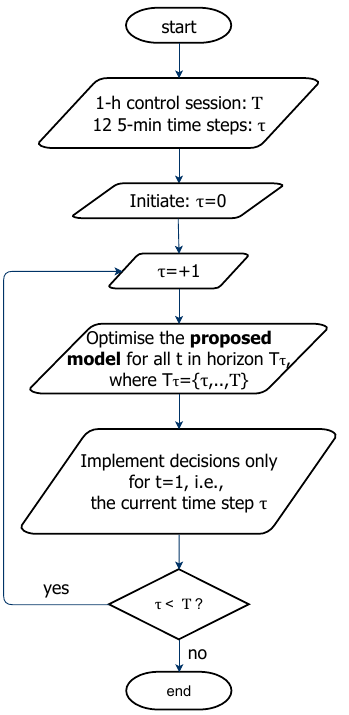
Figure 4. Flow chart of the proposed